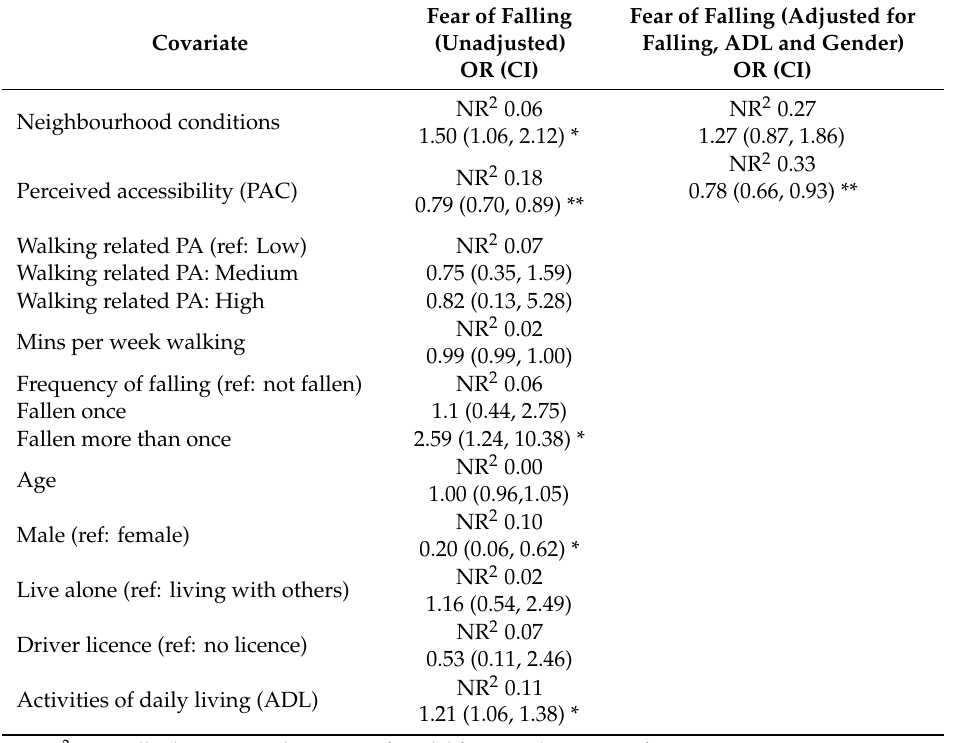
Table 3. Logistic regression models—odds ratios (OR) demonstrate the odds of having reported a fear of falling for each key variable. Fear of Falling (Adjusted for Fear of Falling Falling, ADL and Gender) Covariate (Unadjusted) OR (CI)